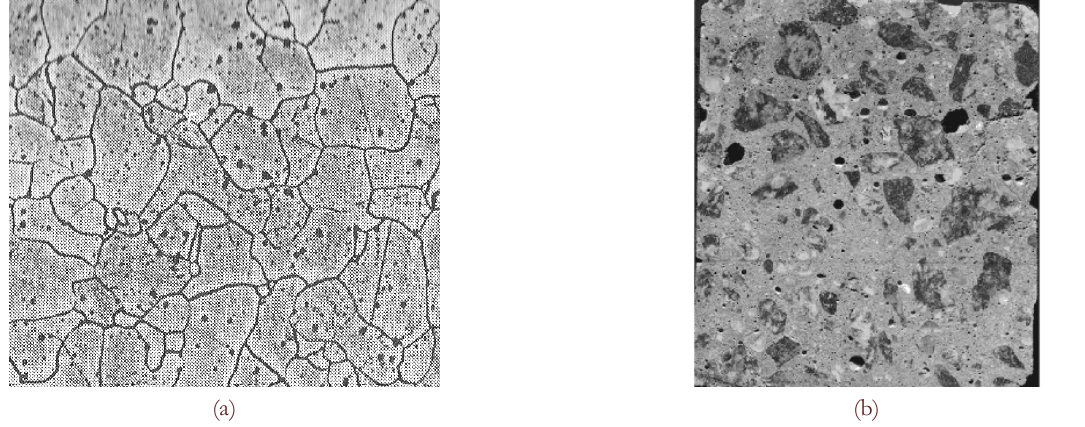
Figure 1: (a) Micrograph of pure iron with ferrite inclusions and crystals having a polygonal shape. (b) Typical concrete material with aggregates, cement paste and